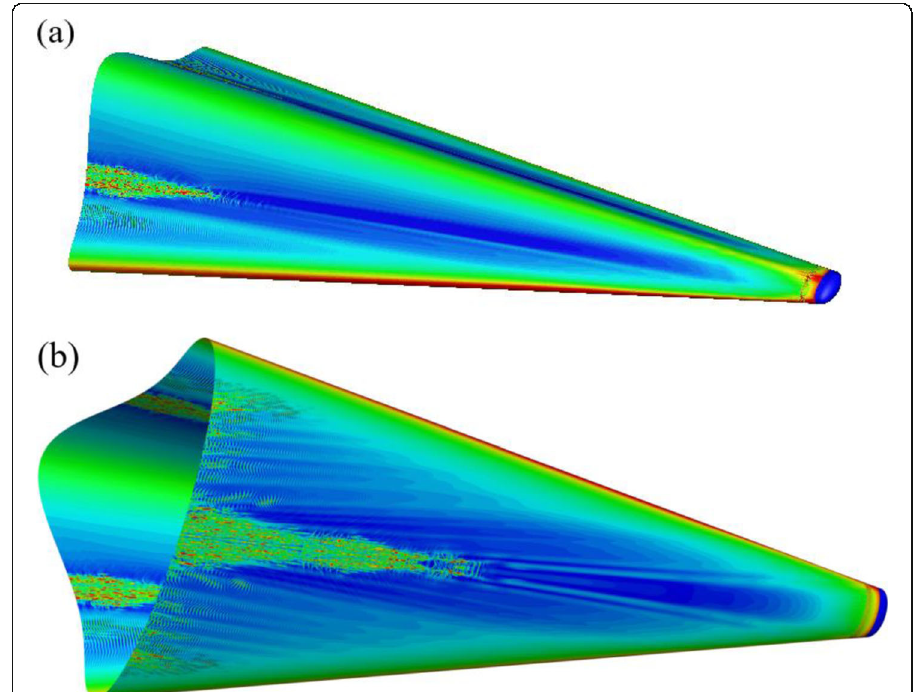
Fig. 6 The distribution of friction resistance coefficients on the surface of the model (upper and lower surfaces)